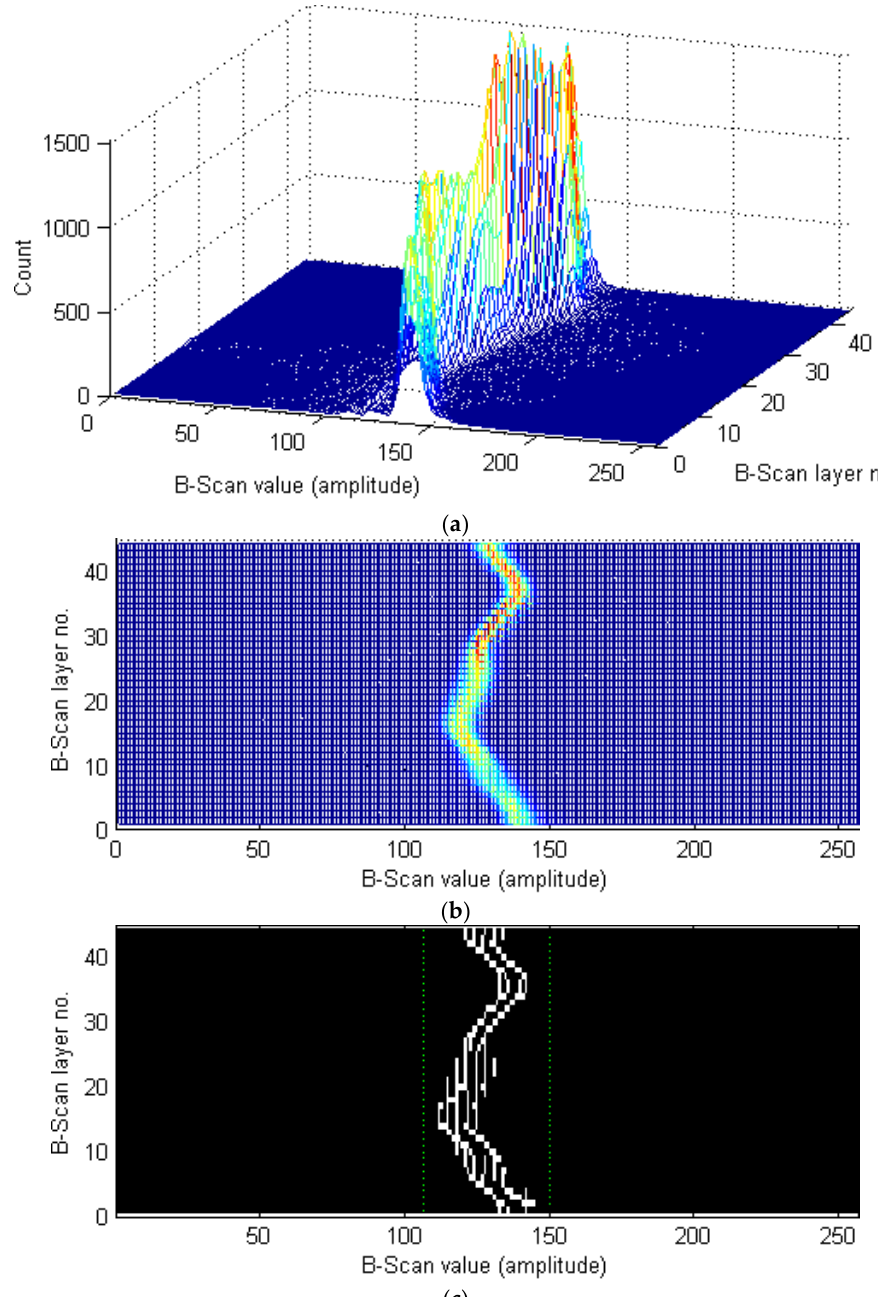
Figure 8. A set of histograms of a series of B-Scan layers: ( a ) a 3D view; ( b ) a top view; ( c ) detected edges and thresholds (shifted).